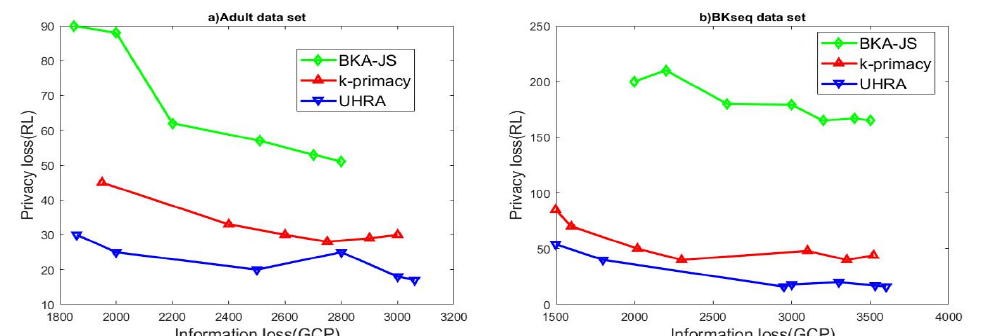
Figure 2. R-U map with regards to various J values.